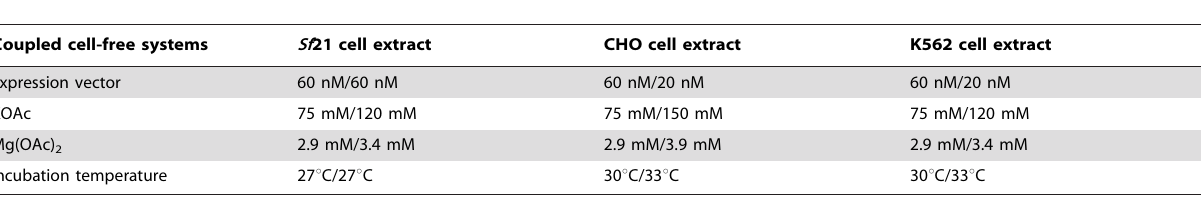
Table 2. Reaction conditions were adapted to CrPV IGR IRES-mediated translation in eukaryotic cell-free systems.